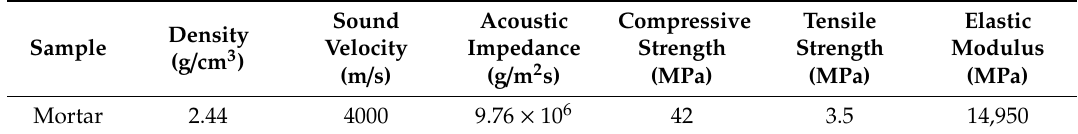
Table 1. Mechanical properties of the mortar